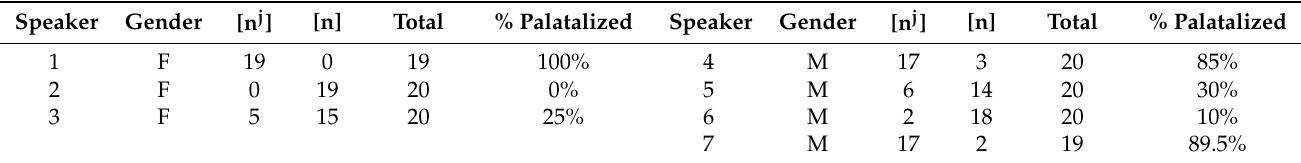
Table 2. Token count and percent palatalized by speaker and gender.